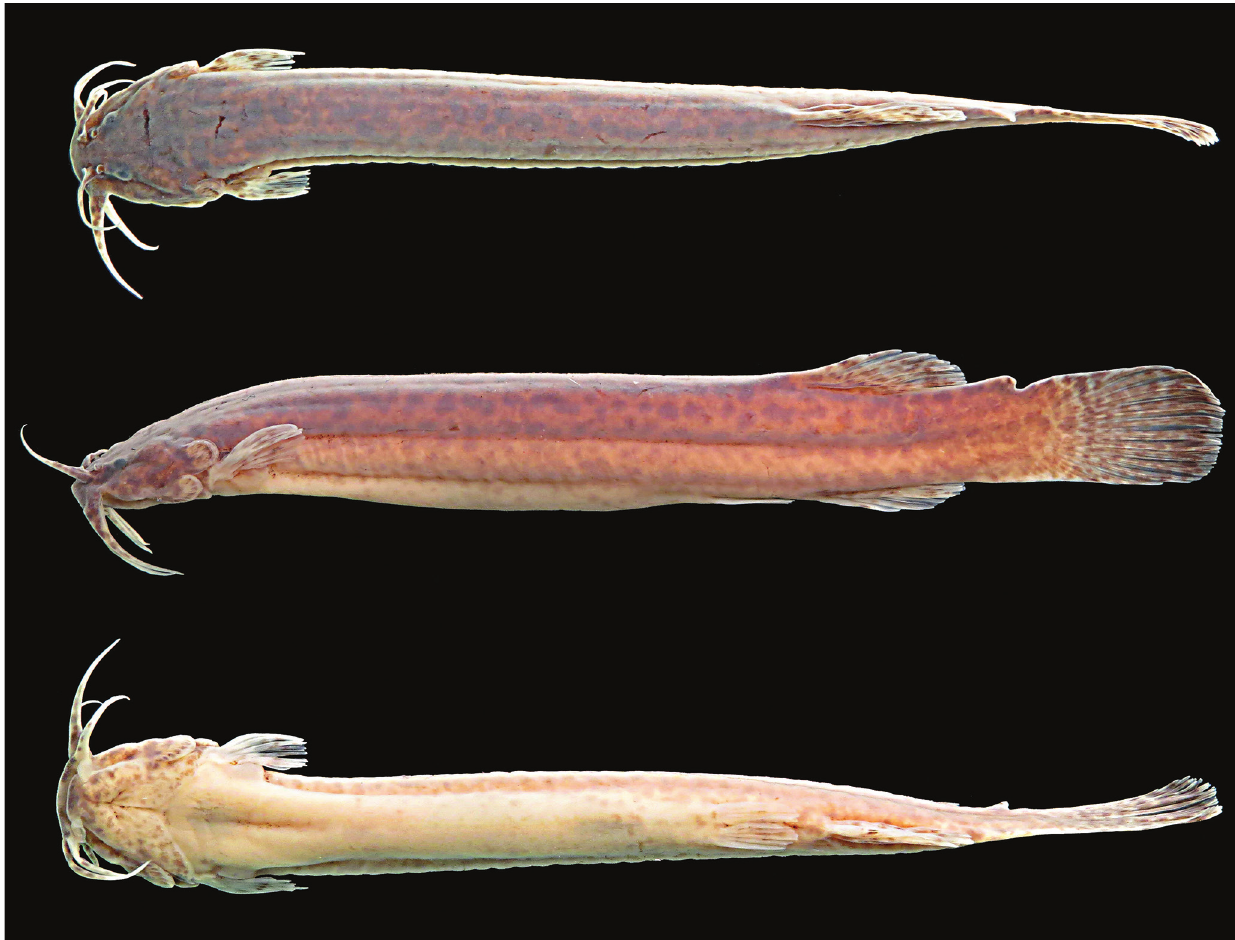
Fig. 1. Ituglanis inusitatus , new species, holotype, UFRGS 21829, 62.2 mm SL; arroio São João, Alegrete, rio Ibicuí basin, Rio Grande do Sul State, Brazil. Cut over the dorsal margin of the caudal peduncle is absent in remaining type